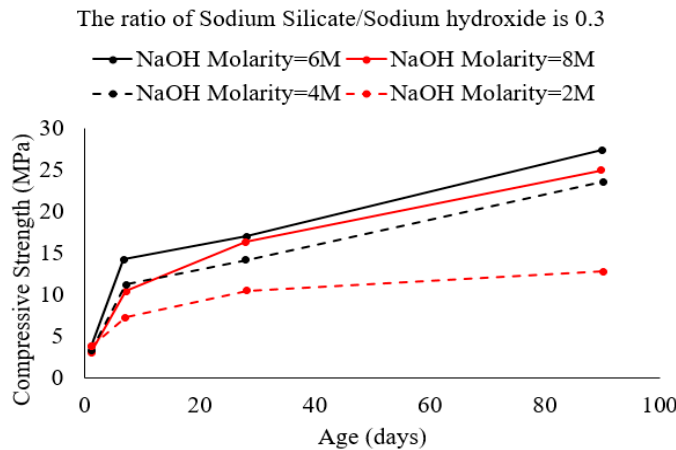
Figure 6. Strength development in mortar with a high-calcium fly ash binder activated using NaOH solution with molarity in the range of 2 M to 8 M [64].